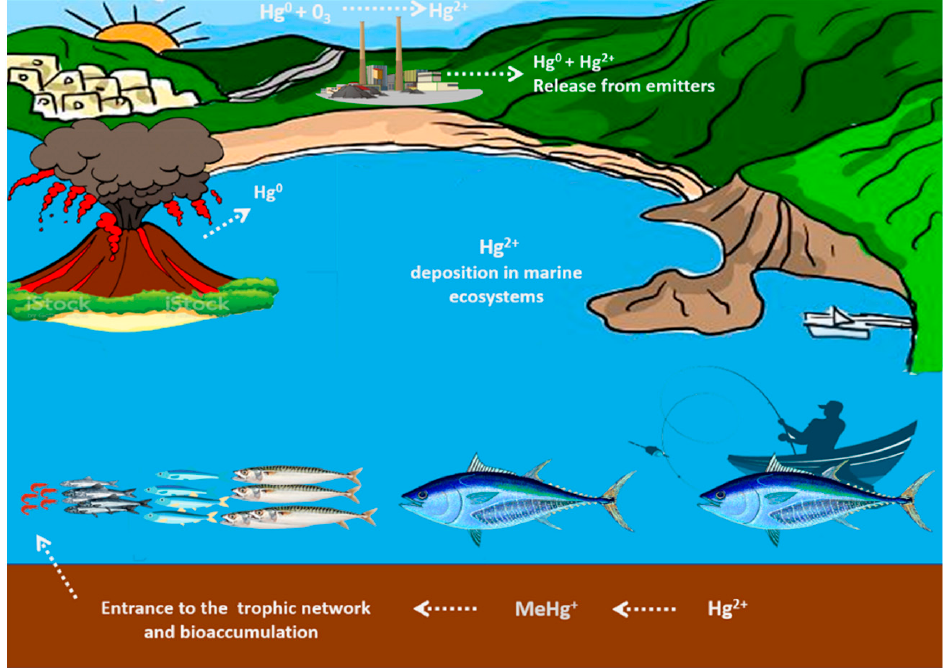
Figure 1. The Hg biogeochemical cycle. Hg pollution of the environment mainly results from natural sources such as volcanic activity and fossil fuels as well as human industrial activities. Hg exists in the ecosystem in elementary, inorganic, and organic forms. These different species can be environmentally as well as biologically converted into each other in soil, air and especially water. In aquatic sediments, inorganic Hg is converted into its organic forms, mainly methylmercury, by microorganisms. This form enters the trophic network via plankton and it accumulates in the passage through small to carnivorous fish at the top of the food chain, via the process of biomagnification, reaching humans through contaminated fish .